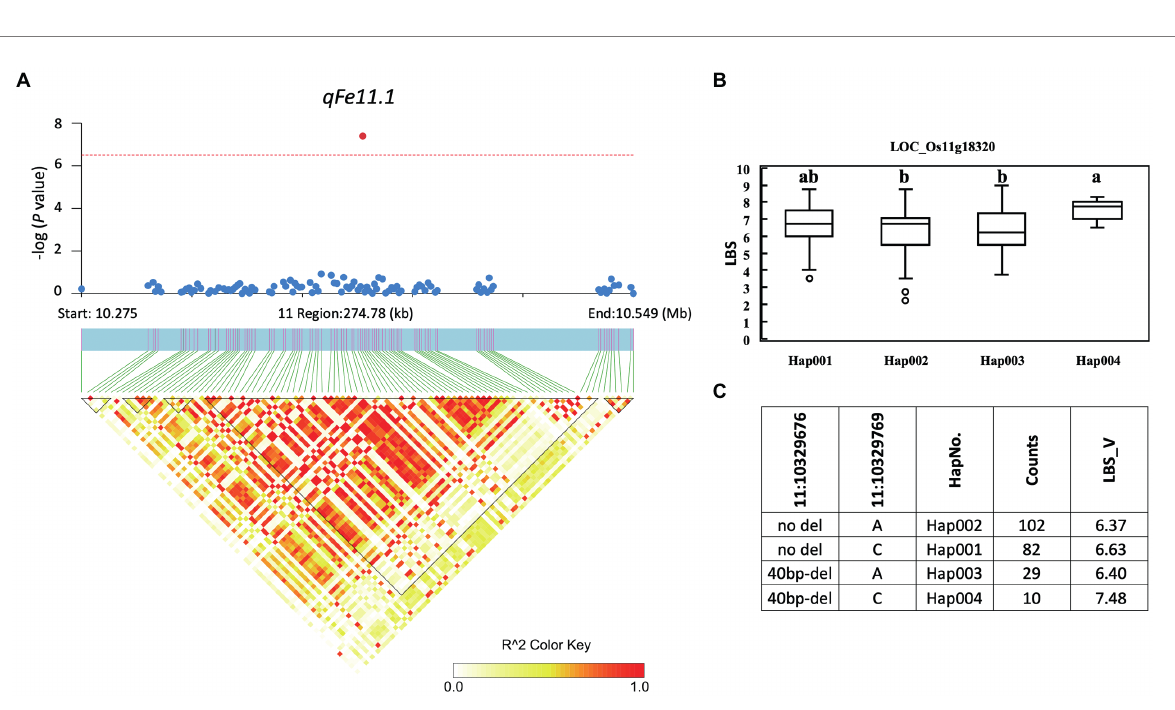
FIGURE 8 Associated regions and haplotype analysis of qFe11.1 . (A) Regional Manhattan plots and LD heatmap across the 275-kb region surrounding the significant SNP. The single red dot above the red line denotes the significant SNP. The black triangles in the LD heatmap represent the haploblocks. (B) Boxplots show the phenotypic distribution of LBS in the LOC_Os0011g18320 haplotype groups. Different letters above each haplotype group show significant difference at p ≤ 0.05 according to Tukey’s HSD test. (C) Haplotype analysis of